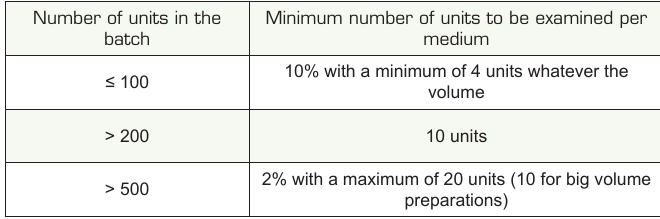
Table 10: minimum number of manufactured units to be examined in accordance with the European Pharmacopoeia